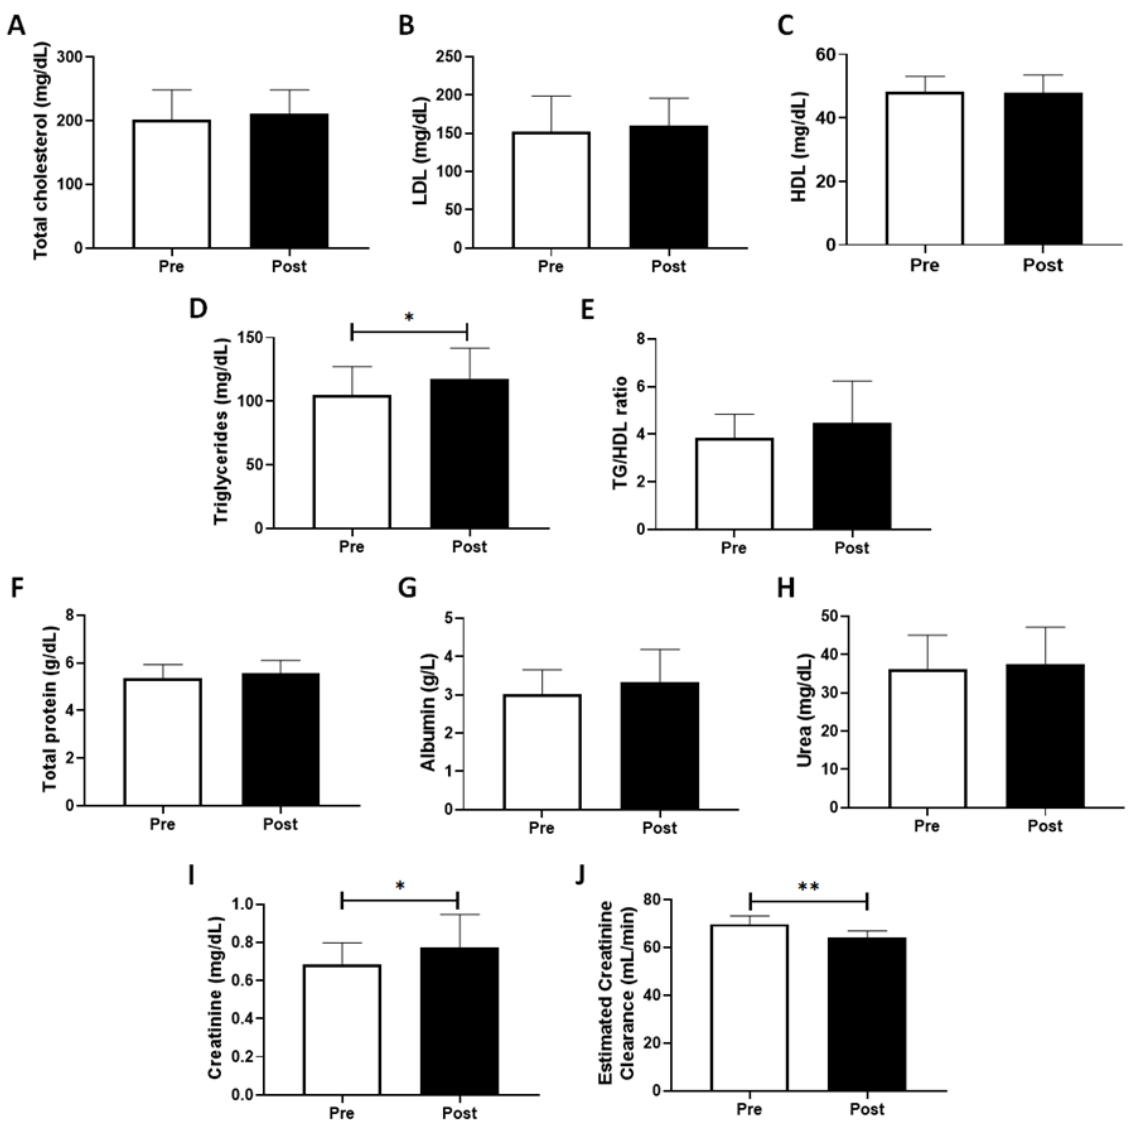
Figure 1. Circulating levels of lipid (total cholesterol ( A ), LDL ( B ), HDL ( C ), triglycerides ( D ) and TG/HDL ratio ( E )) and protein (total protein ( F ), albumin ( G ), urea ( H ), and creatinine ( I )) profiles, as well as estimated creatinine clearance ( J ), mean, and standard deviation (SD) of participants be- fore (pre) and after (post) one year of social isolation imposed in response to the COVID-19 pandemic. * p < 0.05; and ** p < 0.01. Table 2. Functional physical tests (GS, in meters per seconds (m/s); and TUGT, in seconds (s)) and muscle strength measure (HG, in kilograms of force (kgf)), presented as mean and standard devia- tion (SD), of older women volunteers participating in the study.